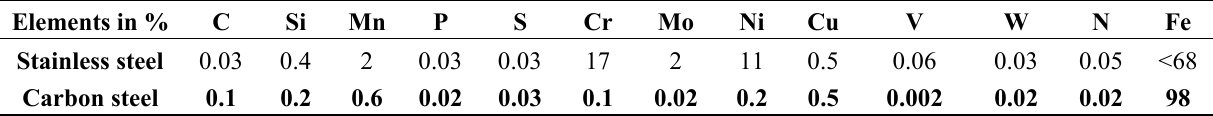
Table 1. Chemical composition of the carbon steel and of the stainless